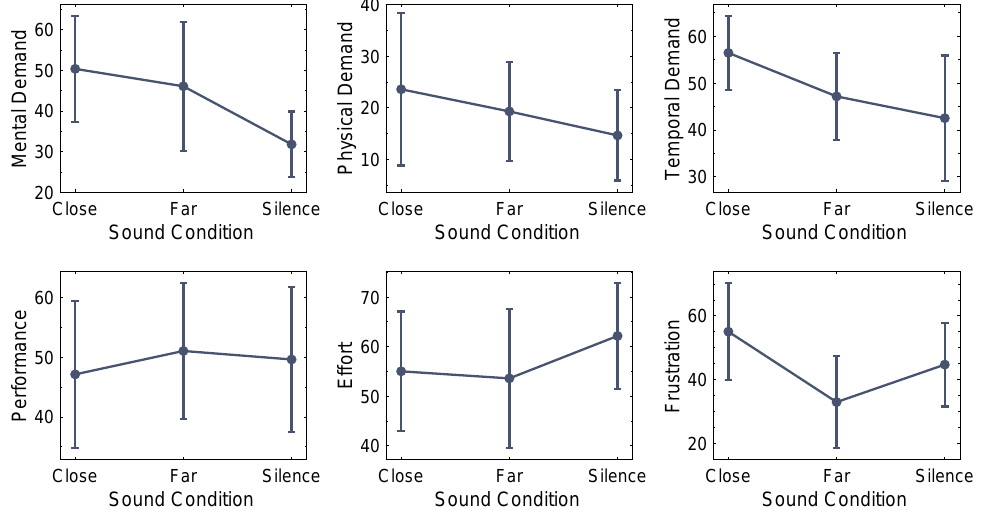
Figure 6. Means and 95% confidence intervals of perceived task load